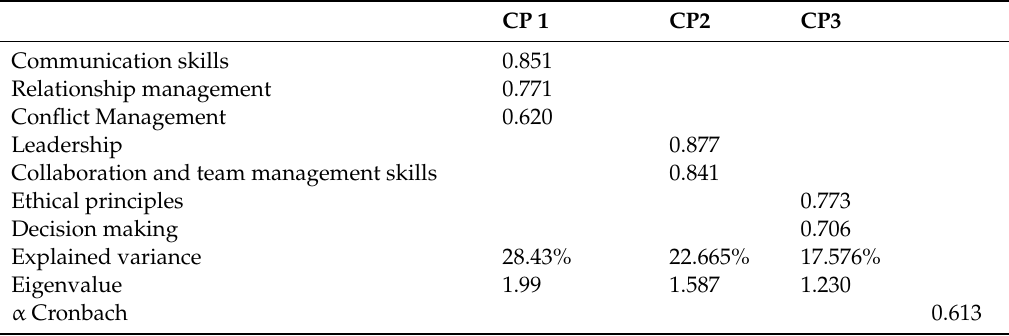
Table 5. Principal Component Analysis (PCA) of core